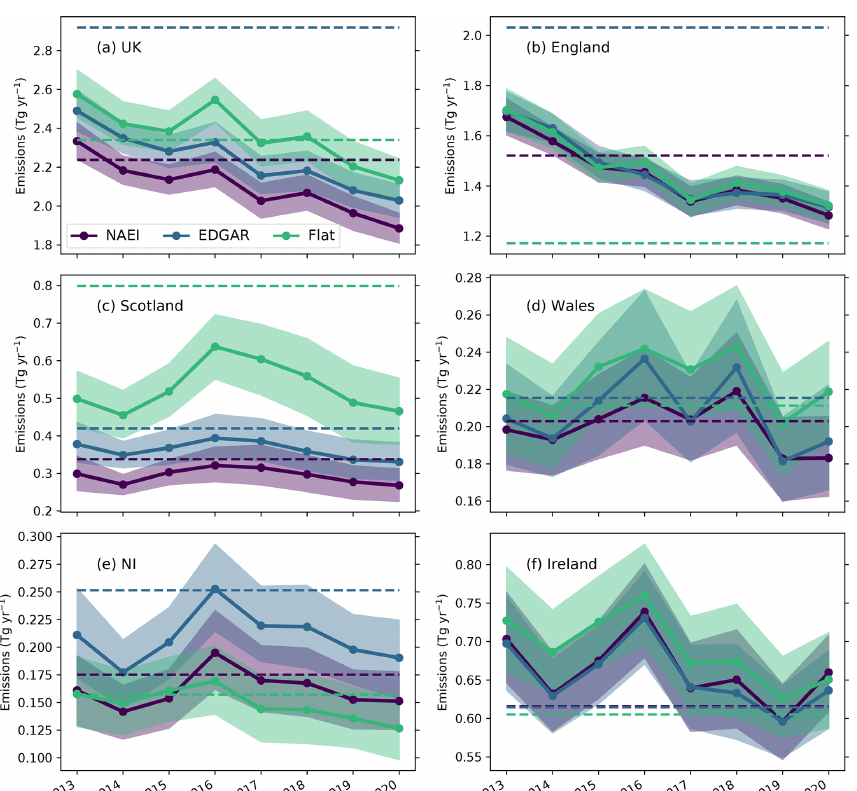
Figure 9. Annual mean emissions between 2013 and 2020 for inversions using different prior distributions from the NAEI (purple), EDGAR (blue) and a flat distribution (green). Estimates are shown for (a) the UK, (b) England, (c) Scotland, (d) Wales, (e) Northern Ireland (NI) and (f) the Republic of Ireland. Shading represents the 95% confidence interval. Dashed lines represent the magnitudes of the respective